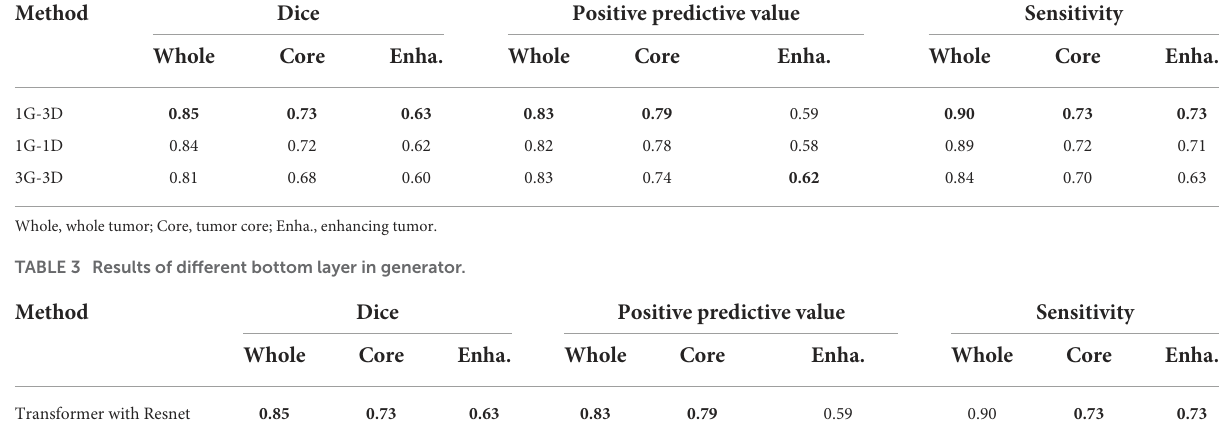
TABLE 2 Results of different number of generators and discriminators.